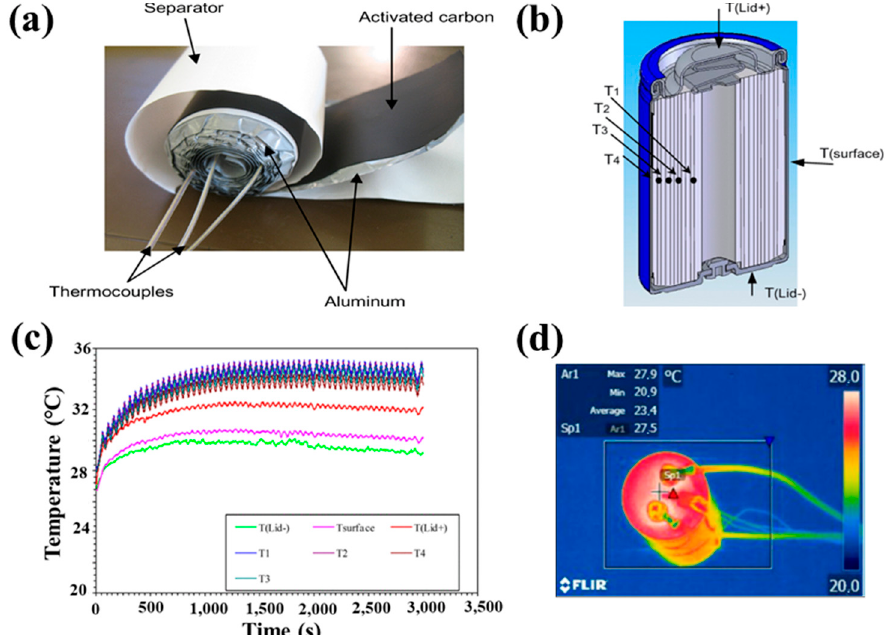
Figure 10. ( a ) SC construction with embedded thermocouple, ( b ) geometric diagram of thermocouple positions, ( c ) plots of internal and external temperature of SC versus time, reproduced with permission from [117], copyright 2011, IEEE, and ( d ) thermal image of capacitor temperature change, reproduced with permission from [118]. Copyright 2016, Springer Nature.